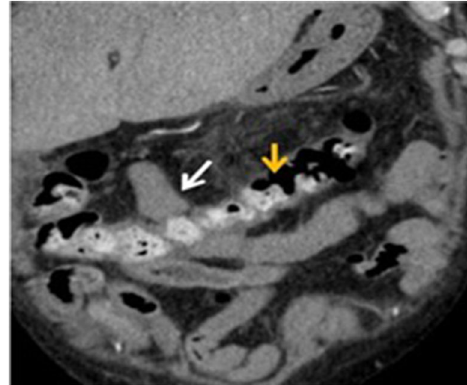
Fig. 8 Bowel wall enhancement. Coronal contrast-enhanced CT shows B pale arterial ischaemia ^ with absent mural enhancement in a segment of small bowel (white arrow). An adjacent segment of small bowel shows mucosal hyperenhancement of thick-walled small bowel (orange arrow), indicating bowel reperfusion